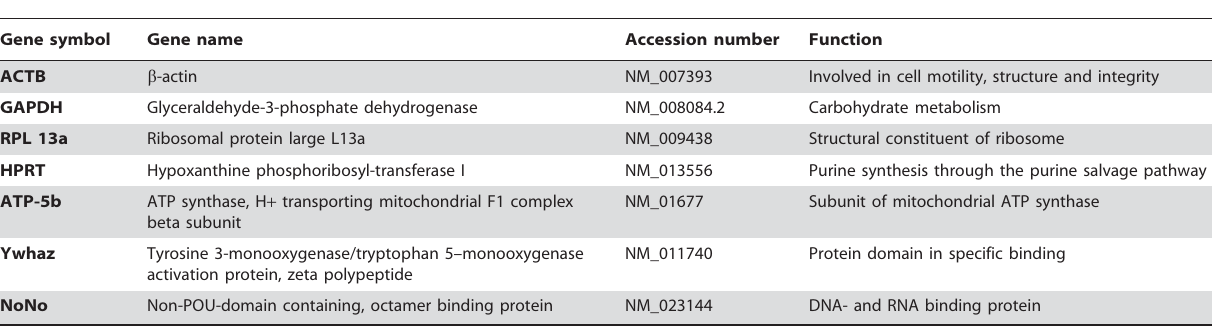
Table 1. Symbols, names, accession numbers and function of the candidate RGs evaluated.